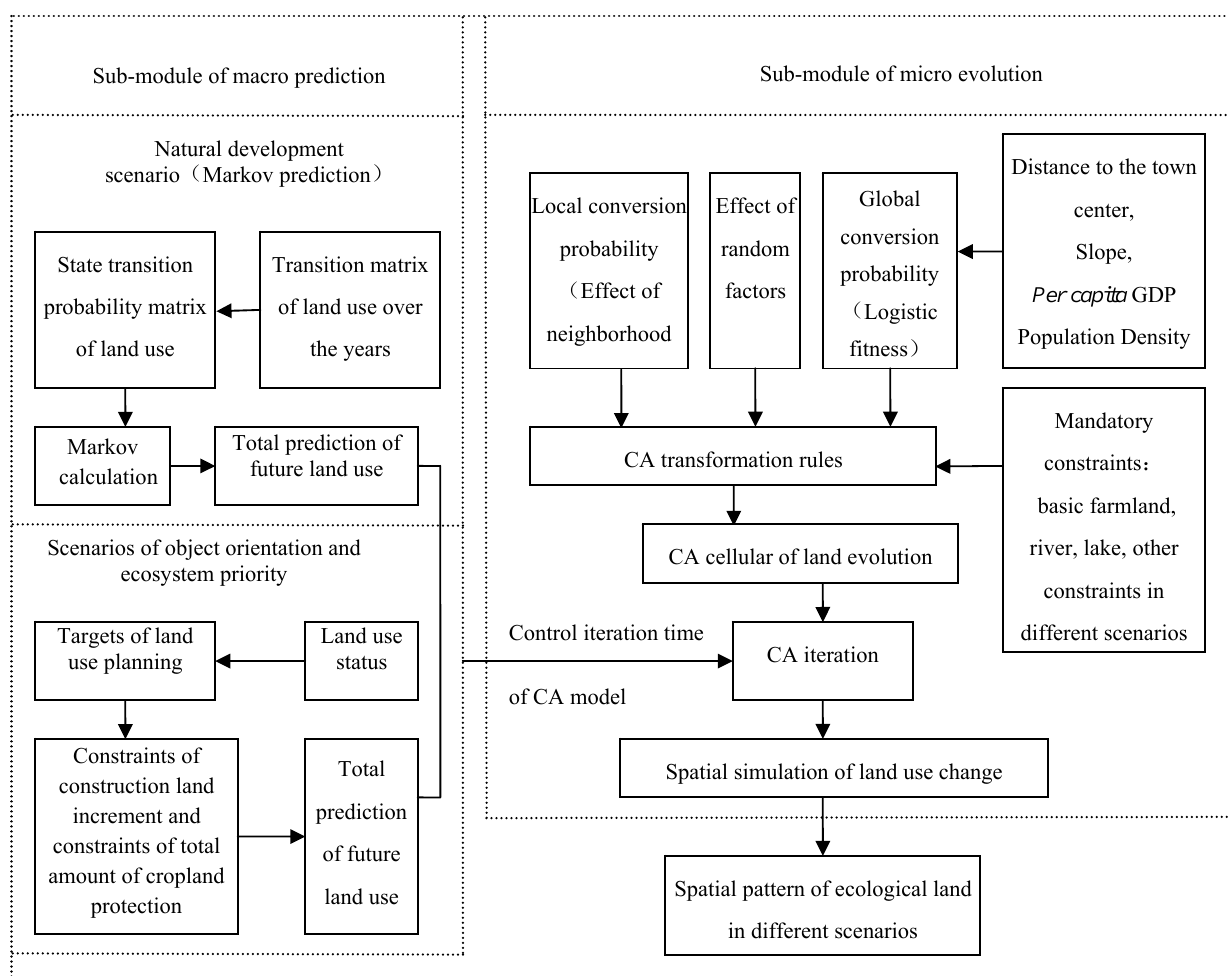
Figure 2. Framework of CA model for ecological land regulation under different